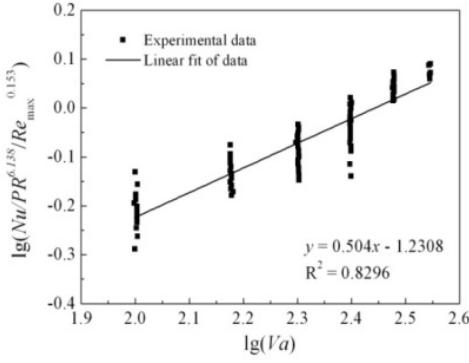
Figure 16. Determination of coefficient n . Appl. Sci. 2017 , 7 , 117